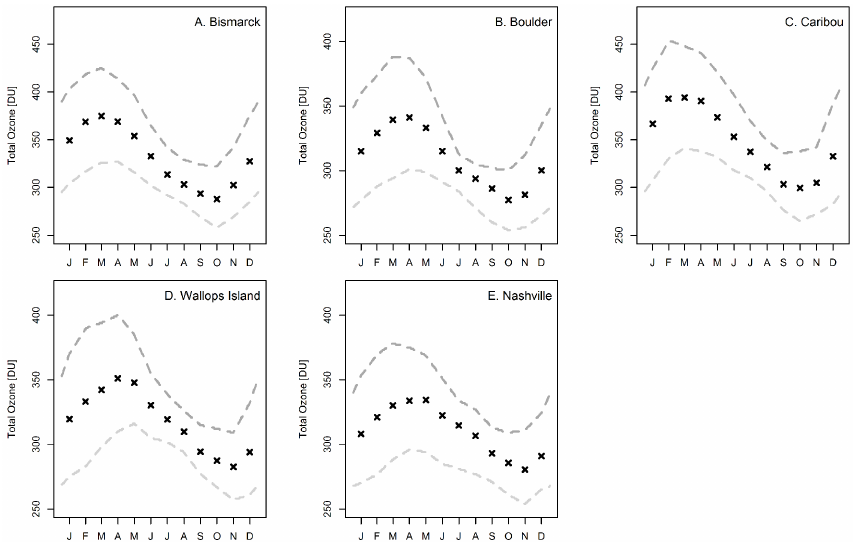
Figure 2. Thresholds for extreme highs (EHOs, dark-grey dashed lines) and lows (ELOs, light-grey dashed lines) of total ozone and clima- tological monthly means of total ozone (black crosses) at (a) Bismarck, (b) Boulder, (c) Caribou, (d) Wallops Island, and (e)